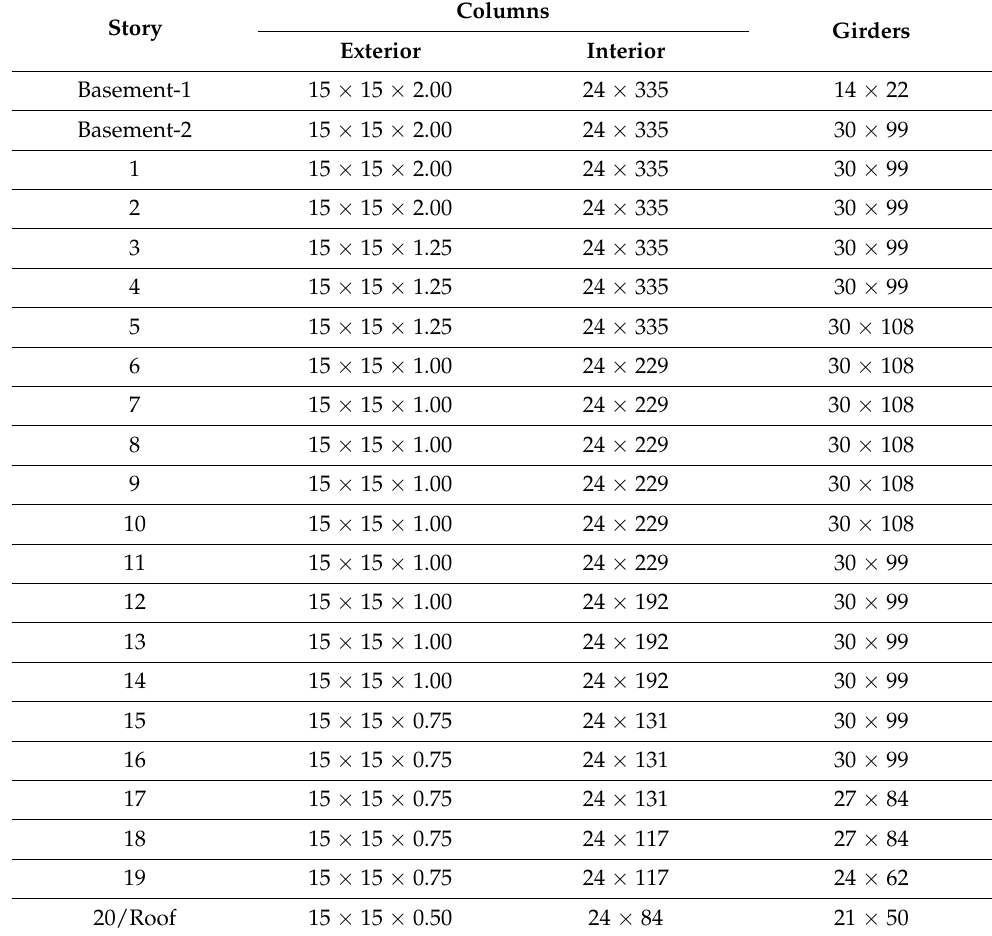
Table 2. Wide-flange and box sections used in Model